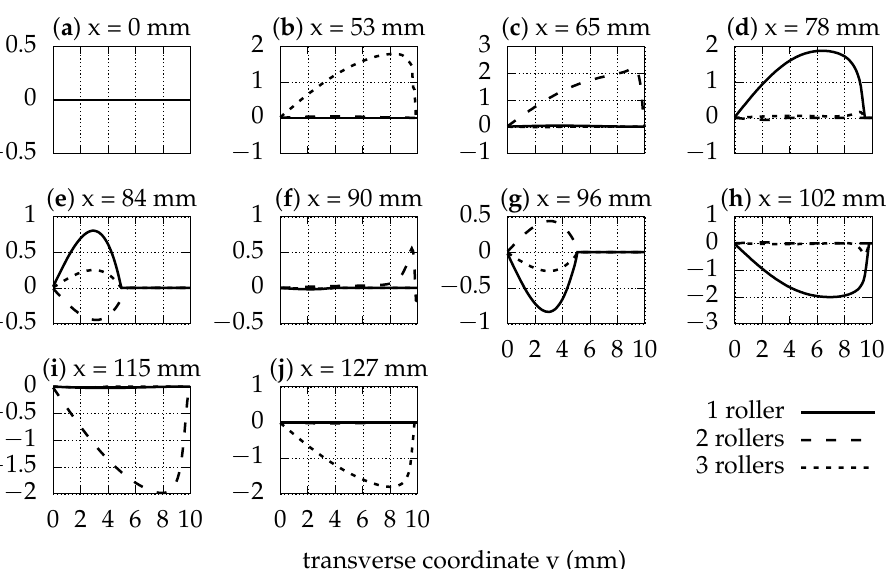
Figure 16. Vertical velocity v profiles at successive longitudinal positions x ( a – j ) for various numbers of rollers, c = 5 mm/s, RO = 0.6 and n =